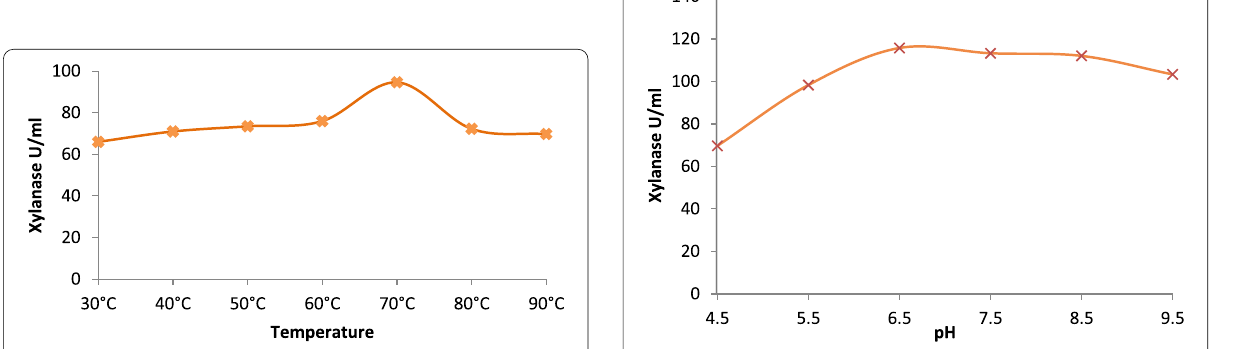
Fig. 4 Temperature optima of purified xylanase Fig. 5 pH optima of purified